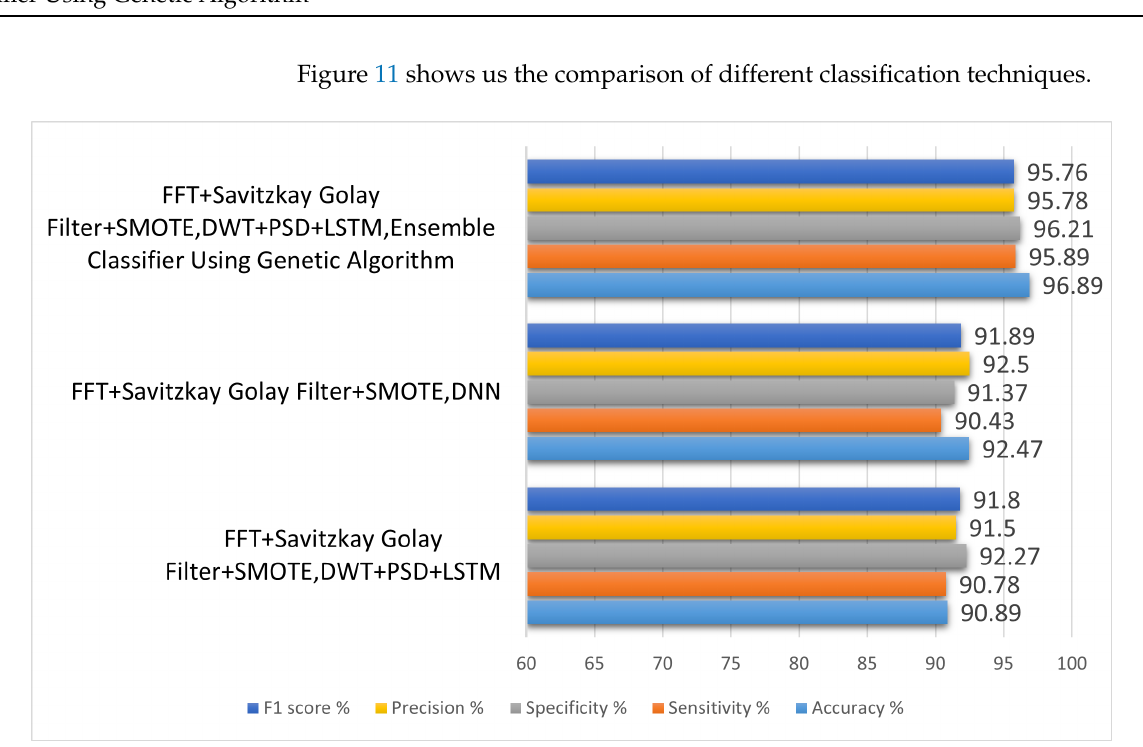
Figure 11. Analysis of different classification techniques in proposed